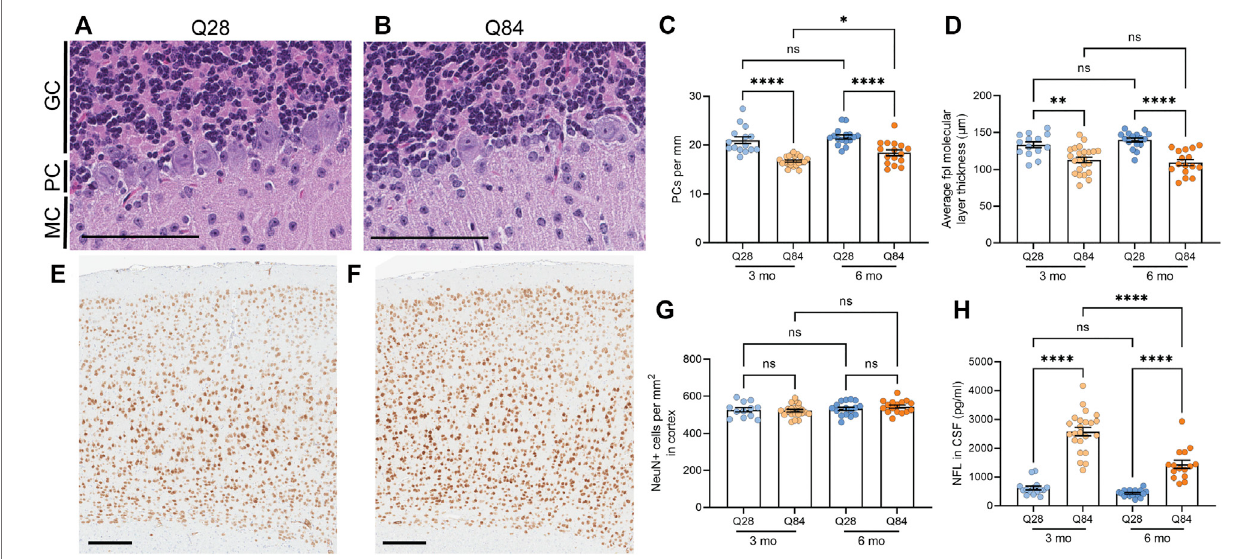
FIGURE2| SCA3miceshowneuronallossinthecerebellumandincreasedNFLlevelsintheCSF. (A – B) RepresentativeimagesofthecerebellarPurkinjecelllayer in Q28 (A) and Q84 (B) mice at 6 months of age. Slides were stained with H&E. MC: molecular cell layer; PC: Purkinje cell layer; GC: granular cell layer. Scale bars are 100 µm. (C) Average number of Purkinje cells (PCs) per mm of the Purkinje cell layer of the cerebellum in Q28 and Q84 animals at 3 and 6 months of age. (D) Average molecular layer thickness at the posterolateral fi ssure (fpl) in the cerebellum of Q28 and Q84 animals at 3 and 6 months of age. (E – F) Representative images of the cortex stained with NeuN in Q28 (E) and Q84 (F) mice at 6 months of age. Scale bars are 200 µm (G) Number of NeuN-positive cells per mm 2 in the cortex of Q28 and Q84 animals at 3 and 6 months of age. (H) NFL levels in the CSF of Q28 and Q84 animals at 3 and 6 months of age. For all panels, error bars are the SEM. * p ≤ 0.05, ** p ≤ 0.01, *** p ≤ 0.001, **** p ≤ 0.0001, ns = non-signi fi cant (1-way ANOVA with Tukey ’ s multiple comparisons test).